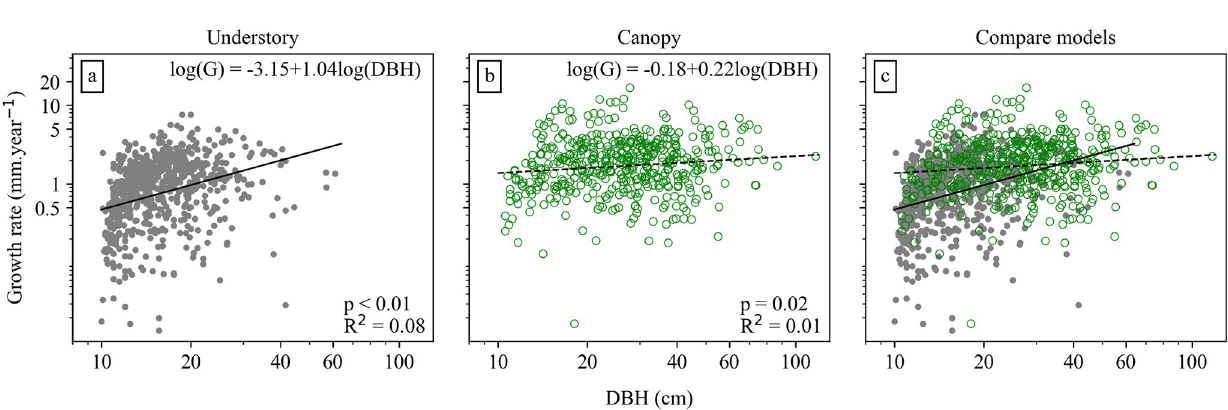
Fig 4. Relationship of diameter growth with DBH for understory and canopy trees. Fitted lines are linear regressions of log-transformed data, with solid lines indicating that the slope is significantly different from zero, and dashed lines that it is not.